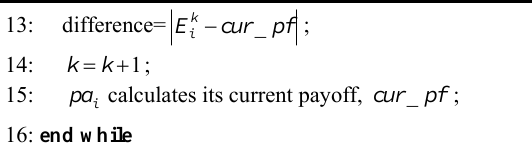
Fig. 1. Algorithm for helping strategy in stage